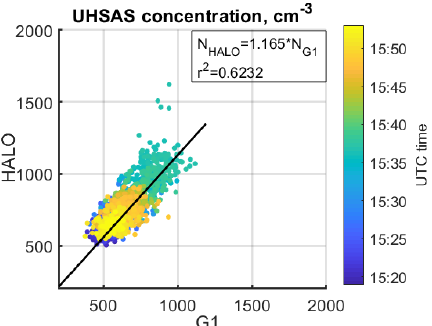
Figure 7. The G1 and HALO comparison for aerosol number con- centration measured by UHSAS (90–500nm) on 9